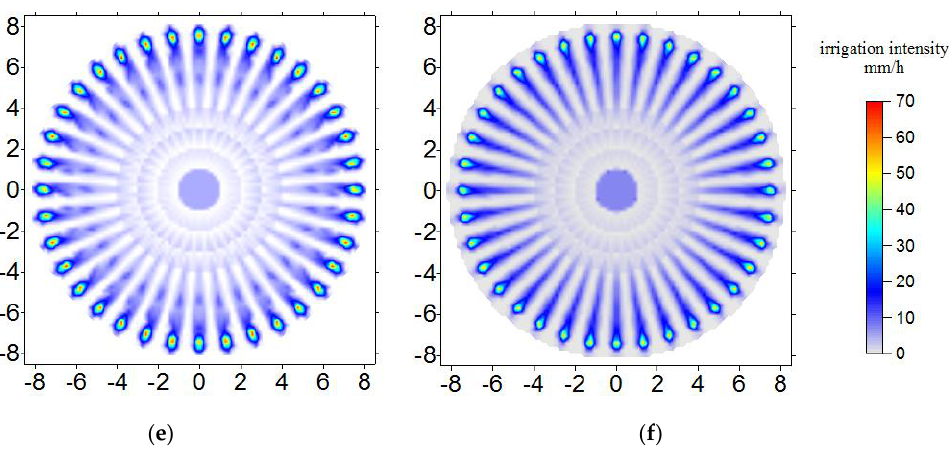
Figure 4. The effect of sediment contents on water distribution pattern with 1.5m mounting height at Figure 4. The e ff ect of sediment contents on water distribution pattern with 1.5 m mounting height 150kPa. Note:( a )clean water,( b )1% sediment content, ( c )2% sediment content, ( d )3% sediment at 150 kPa. Note: ( a ) clean water, ( b ) 1% sediment content, ( c ) 2% sediment content, ( d ) 3% sediment content, ( e )4% sediment content, ( f )5% sediment content. content, ( e ) 4% sediment content, ( f ) 5% sediment content.